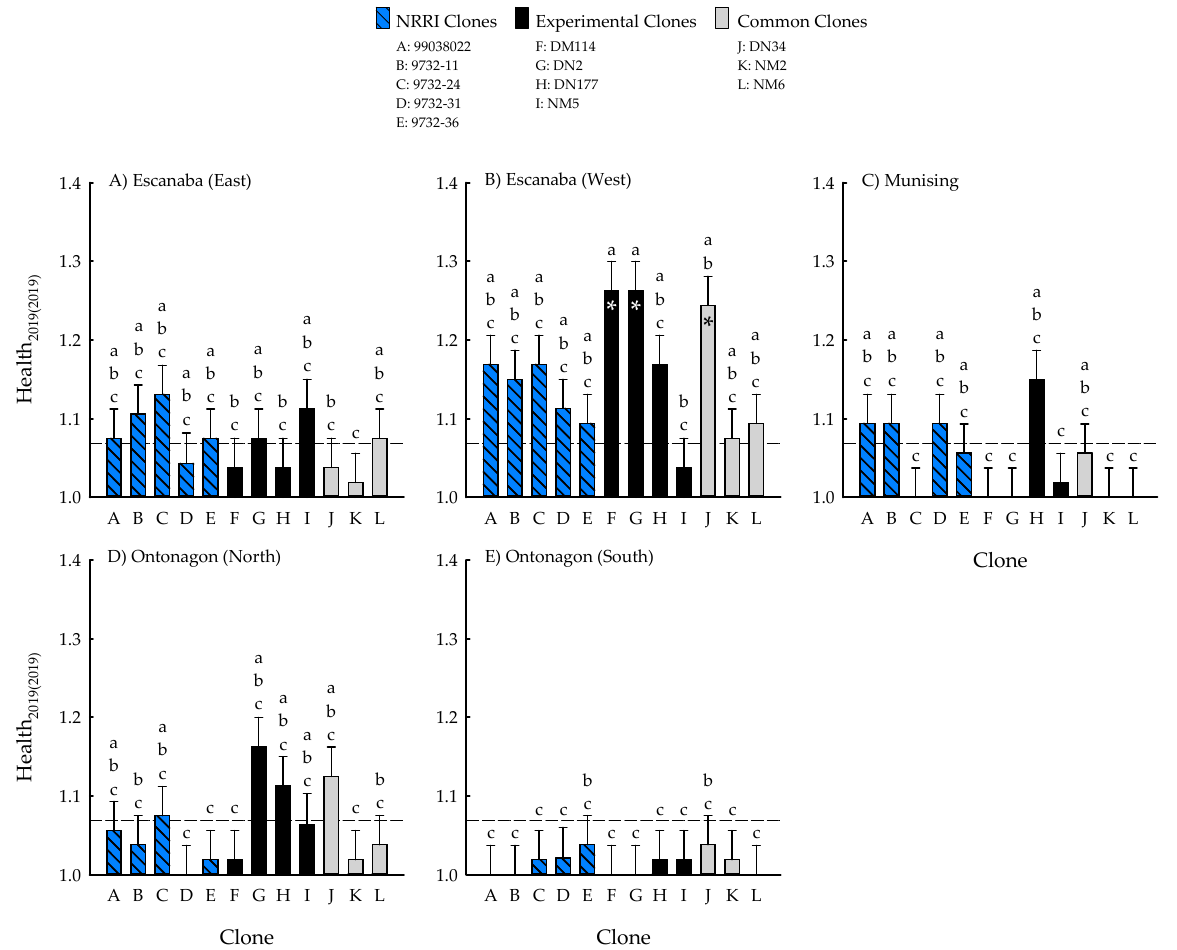
Figure 4. Tree health ( ± one standard error) determined after the 2019 growing season of twelve poplar clones tested in five phytoremediation buffer systems (i.e., phyto buffers) ( A – E ) established in 2019 (i.e., the 2019 buffer group) in the Lake Superior watershed of the Upper Peninsula of Michigan, USA. The dashed line represents the overall mean, and asterisks indicate means different than the overall mean at P < 0.05. Bars with different letters across all buffer × clone combinations are different at P < 0.05. See Materials and Methods for complete tree health definitions (1 = optimal health, 2 = good health, 3 = moderate health, 4 = poor health, and 5 = dead).